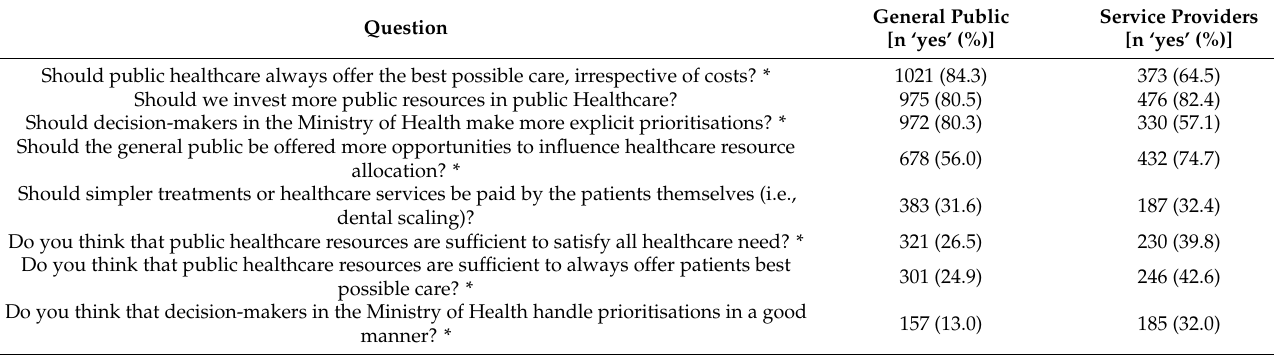
Table 7. Attitudes about the allocation of healthcare resources in